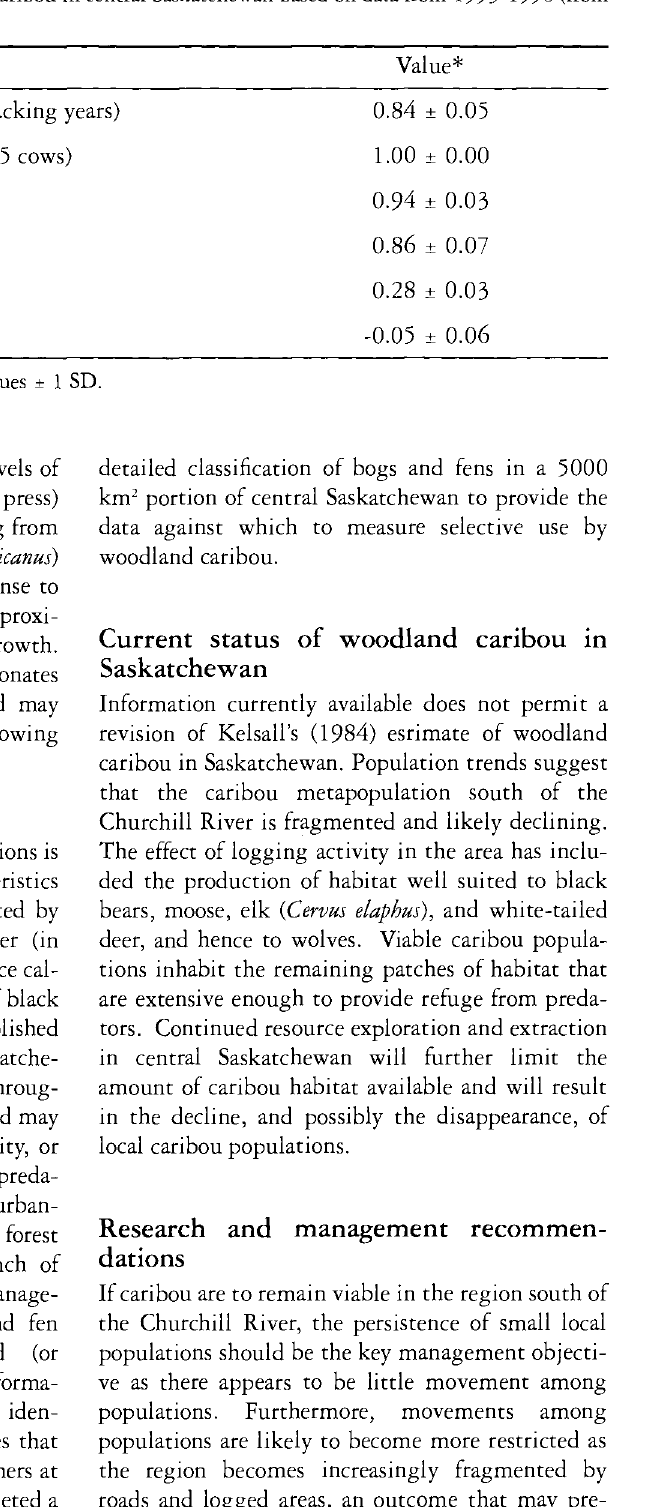
Table 1. Demographic performance of woodland caribou in central Saskatchewan based on data from 1993-1996 (from Rettie & Messier (in